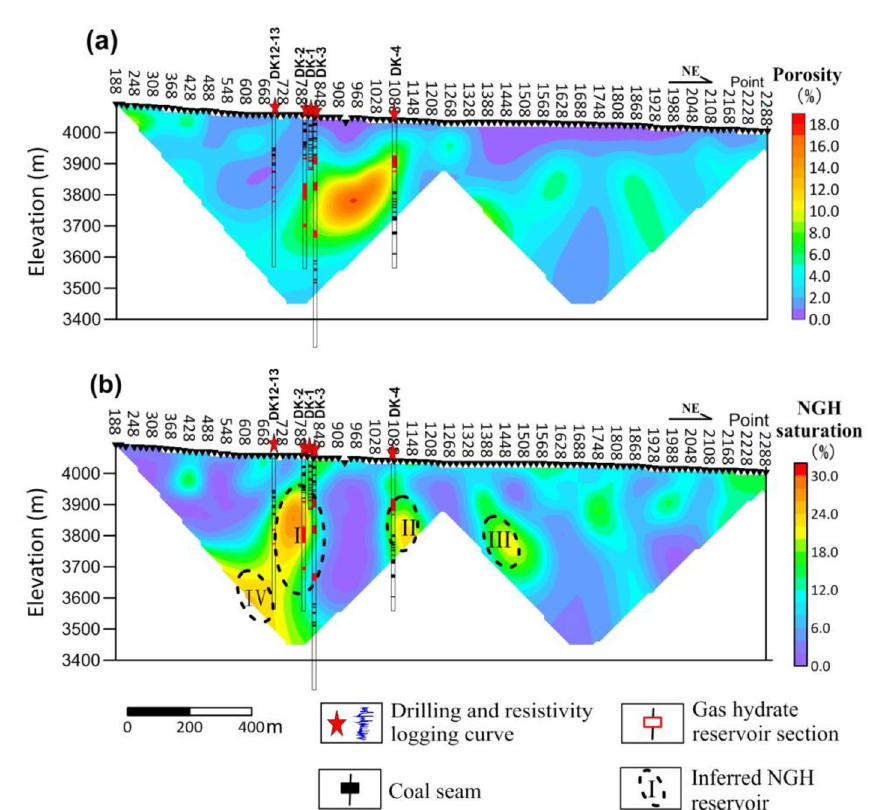
Figure 8. Porosity and NGH saturation sections. ( a ) Section of porosity, ( b ) Section of NGH